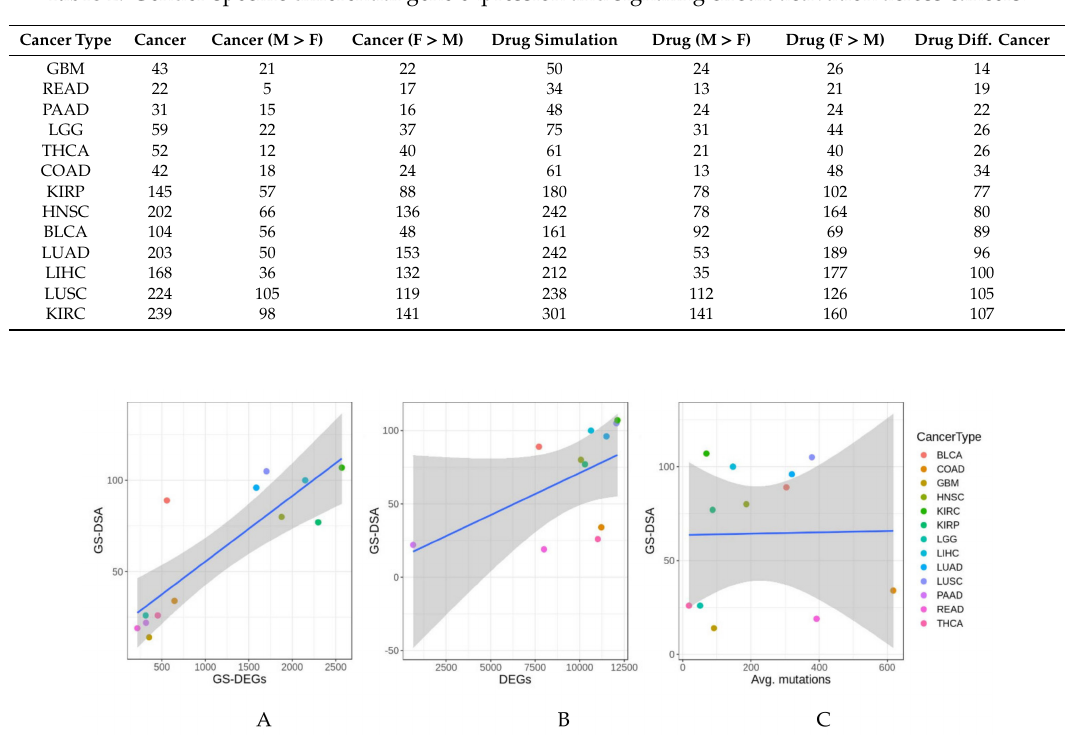
Table 2. Gender-specific di ff erential gene expression and signaling circuit activation across cancers.